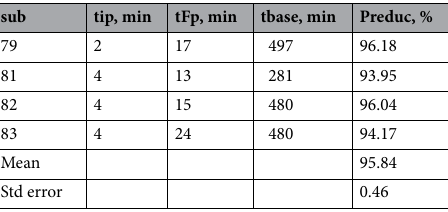
Table 3. Results of data analysis with SVM classifier: workload